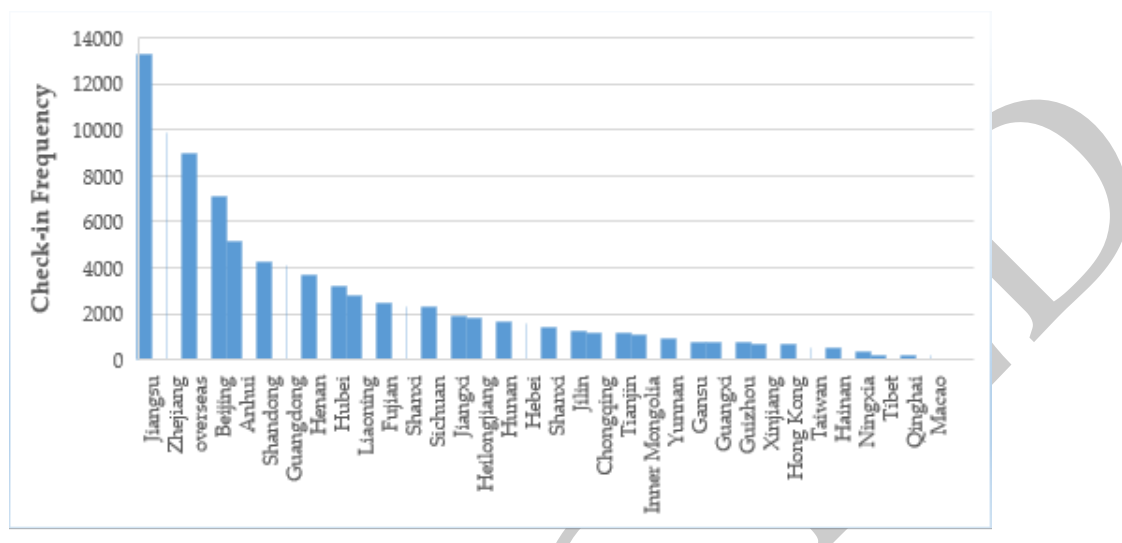
Figure 3. Frequencies of tourists’ check-in from di ff erent provinces.